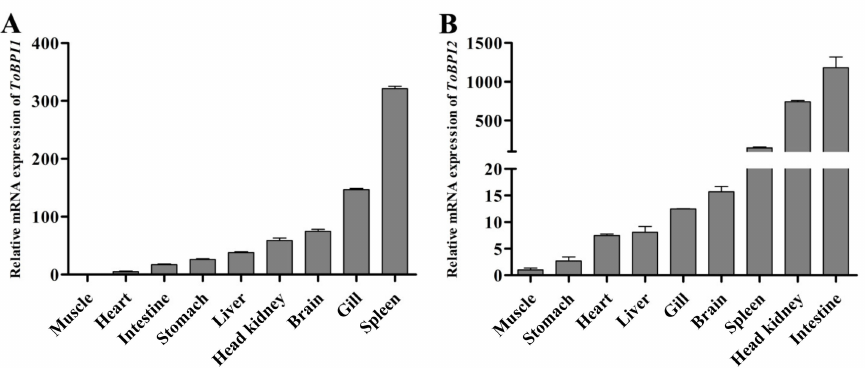
Figure 4. The expression of ToBPI1/LBP ( A ) and ToBPI2/LBP ( B ) in healthy tissues of T. ovatus was detected by real-time quantitative PCR. For comparison, the expression level in muscles was set at 1.0. Each T-line represents the mean standard deviation ( n =